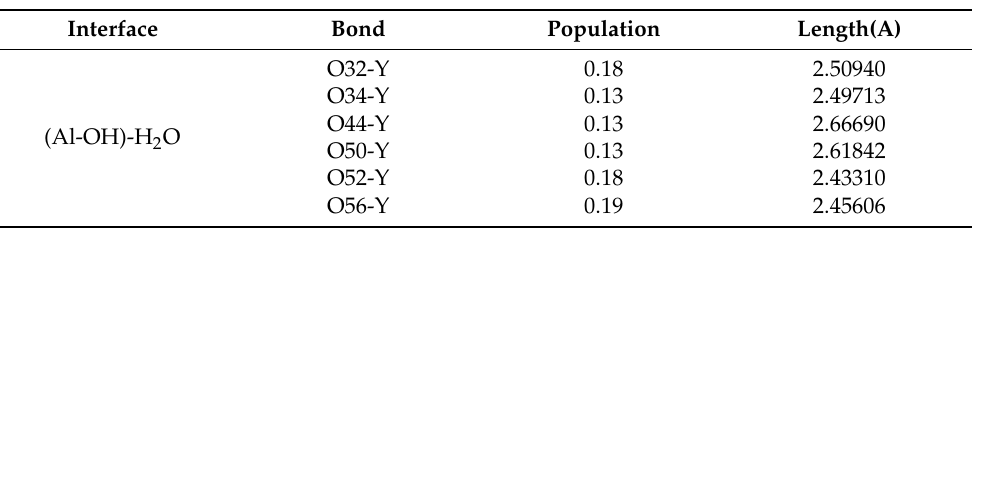
Table 3. Distribution of the Mulliken bonds of Y(III) on the (Al-OH)-H 2 O